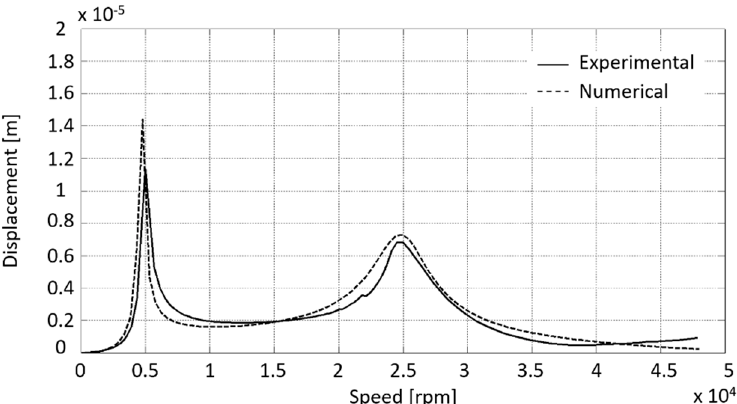
Figure 12. Characterization of the assembled pump in rotation. Unbalance response measured from 0 rpm up to nominal speed (48,000 Rpm) with capacitive displacement sensor placed in correspondence of the higher damper location.